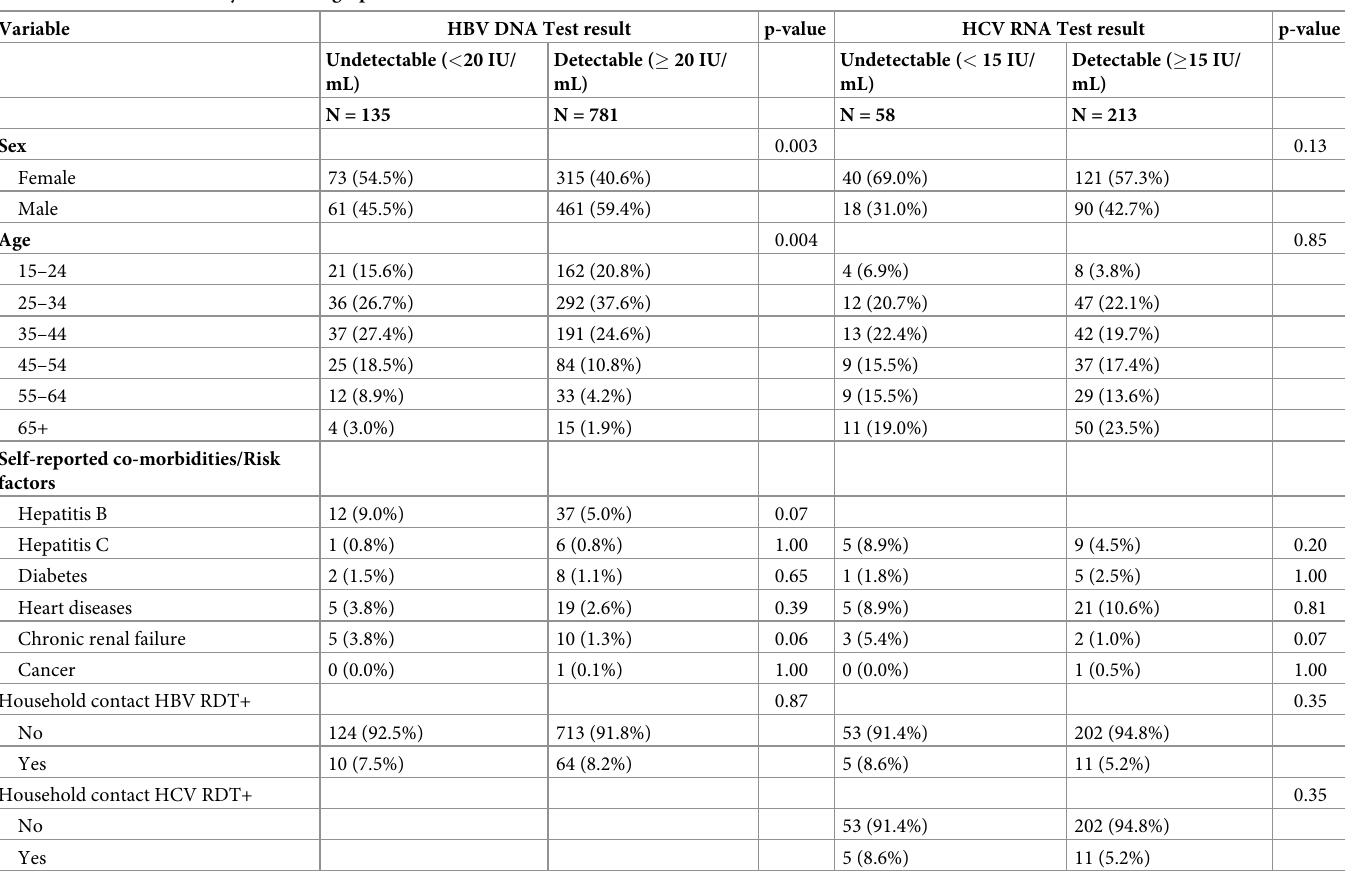
Table 4. Viral load results by sociodemographic and clinical